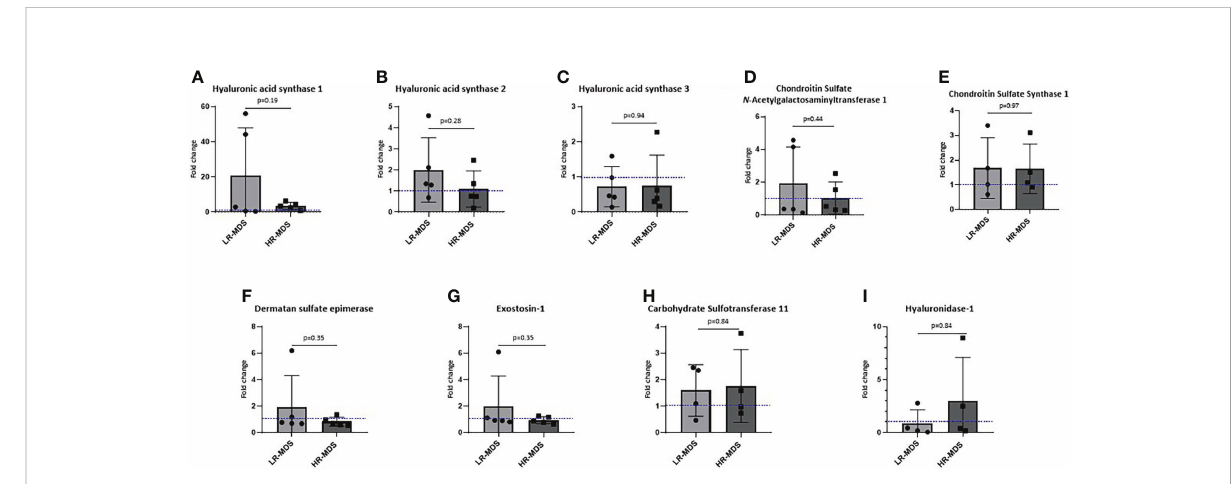
FIGURE 4 Expression analysis of GAG modifying enzymes in MSCs. Gene expression of HAS1 (A) , HAS2 (B) , HAS3 (C) , CSGALNacT1 (D) , chondroitin sulfate synthase-1 (E) , dermatan sulfate epimerase (F) , exostosin-1 (G) , carbohydrate sulfotransferase-11 (H) and hyaluronidase-1 (I) analyzed using quantitative real-time PCR. Bars represent mean ± SD for N=5 MDS samples expressed as fold change relative to the healthy MSC sample, shown as the dotted line at ordinate value of 1. Differences between the two MDS groups as determined by unpaired t-test are shown by the p value.